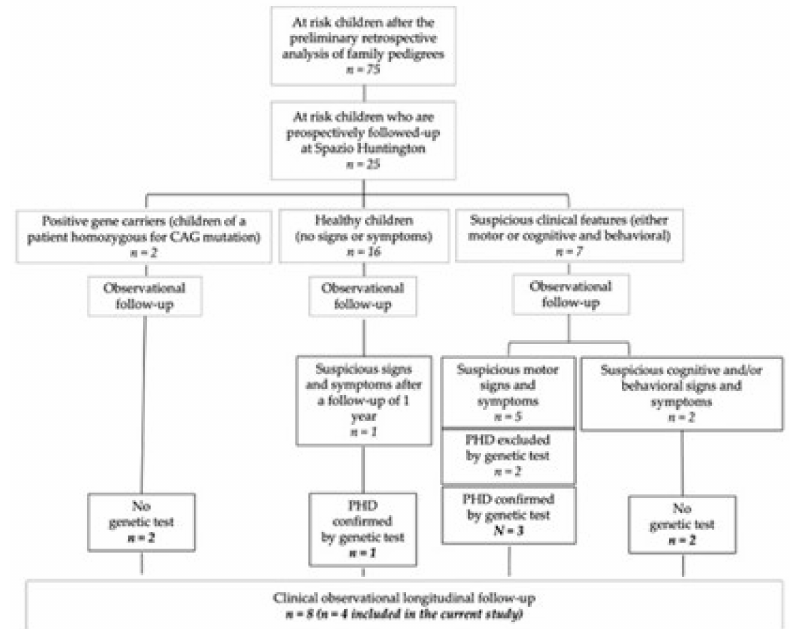
Figure 1. Stratification of Spazio Huntington cohort. Flow chart showing the strategy of selection and stratification of the cohort, starting from a preliminary datasheet analysis of pedigrees and further interviews to families which were then met at “Spazio Huntington—A Place for